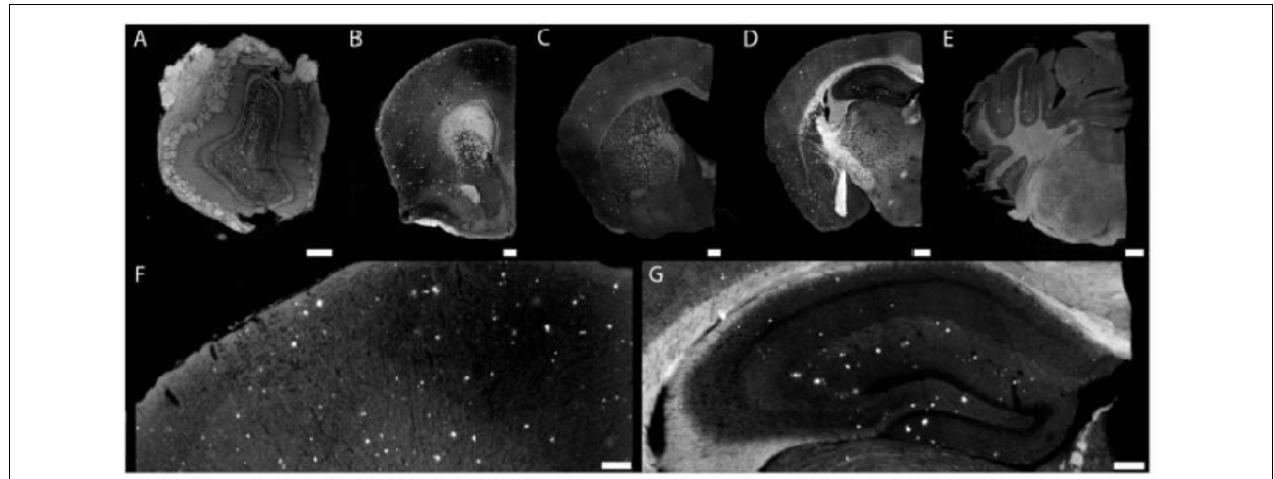
FIGURE 1 | Injected targeted liposomes cross the blood–brain barrier of APP/PSEN1 mice and labeled parenchymal Ab deposits. Composite images (A–E) of olfactory bulb (A) showing plaque pathology within the granule cell layer. Nanoparticles bound to plaques at the level of the septo-striatum (B). Cortical pathology at the septo-diencephalic (C) . Hippocampal and cortical pathology (D) within the caudal diencephalon. Binding to cerebellar plaques (found within APP mice) within the rostral mesencephalon (E). An example of cortical plaque pathology (F) visualized at 10 × magnification. Hippocampal plaque pathology (G) is similar to previously reported studies. Scale bar = 100 mm (adopted with permission from Tanifum et al., 2012).